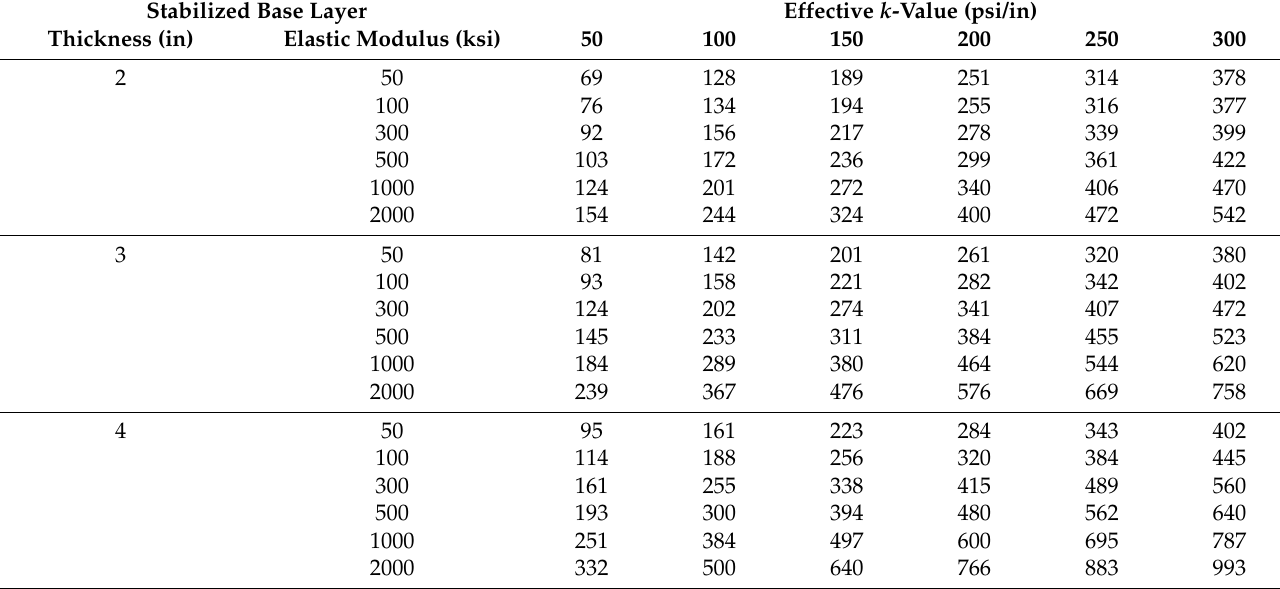
Input variables with values and composite k -values computed by the FE simulations (1 in = 25.4 mm, 1 ksi = 6.89 MPa, 1 psi/in = 271 kN/m 3